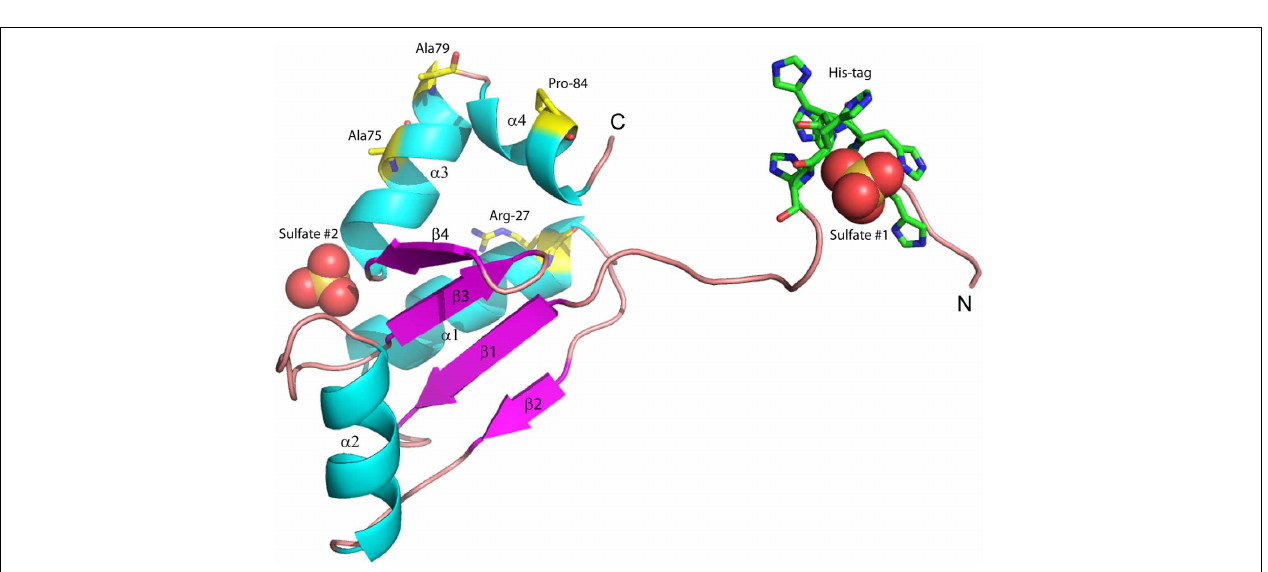
FIGURE 2 | Structure of wild-type glutaredoxin from Synechocystis sp. PCC 6803. Magenta arrows correspond to β -strands; cyan coils represent α -helices. Sulfate anions are shown in the space filling